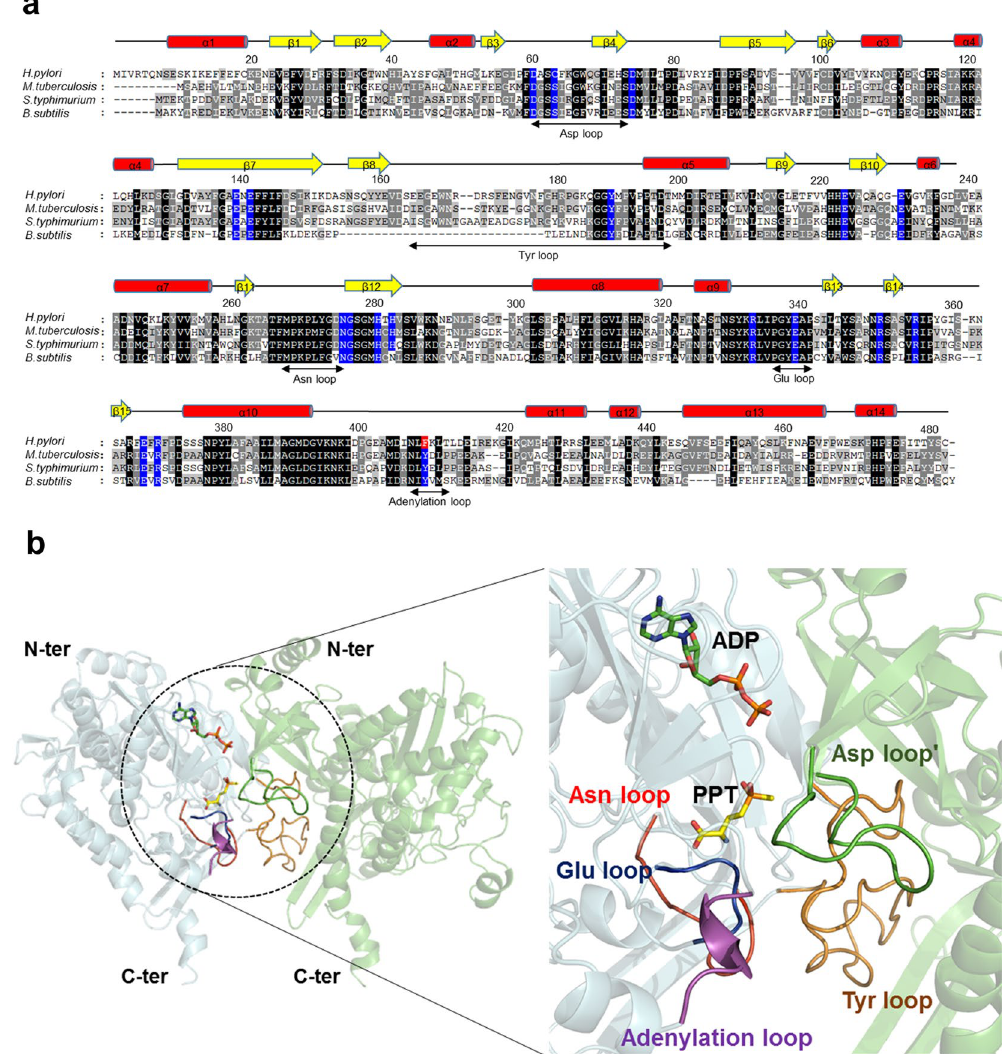
Figure 2. Catalytic and regulatory loops of Hpy GS. ( a ) Multiple sequence alignment of Hpy GS with other homologous GS sequences in bacteria. The highly conserved residues are indicated by black boxes. The active site and catalytic residues are indicated by blue boxes. The tyrosine residue replaced to phenylalanine in Hpy GS is coloured in red box. ( b ) The catalytic and regulatory loops were well conserved, completing the active site between the subunit-subunit interfaces. The Asp loop was contributed from the neighbouring